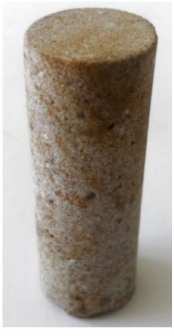
Figure 5. Sandstone sample core.